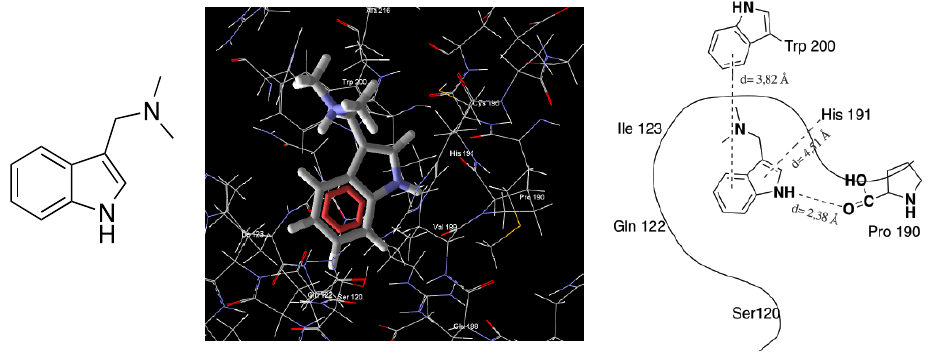
Figure 9. Structure of gramine and its pose at the PP2A-C binding site (Right, schematic view). According to the computational prediction based on molecular docking, the presence of an ionizable tertiary amine was preserved to favor interaction with PP2A, backed by the PP2A interactive behavior of some basic amines such as protamine. The aromatic indole scaffold presented in gramine would be highly stabilized (reducing the rate of the retro-Mannich reaction) if the aromatic nitrogen was alkylated. Thus, several substitutions were challenged, for instance, benzyl, n-butyl, propargyl, and so on, which in turn could generate an additional hydrophobic interaction with neutral amino acids present in the binding site of PP2A-C, far from the phosphate ester hydrolysis catalytic triad [165]. Fi- nally, substitution at C5 of the indole core was diversely probed, incorporating methyl, halogens, or no substitution, to assess the different interactive possibilities with the en- zyme [166]. Three dozen gramine derivatives were prepared by this straightforward method, and the ionized formulation facilitated drug solubility and their testing in further in vivo models. Their ability to recover phosphatase activity was monitored by the pNPP method in SH-SY5Y cultures subjected to OA. They showed a docile increase in phospha- tase activity. In parallel, using patch-clamp recordings and fluorescence experiments with the Ca 2+ -sensitive probe Fluo-4, we appreciate an important blocking effect on high K + - evoked depolarization, whereby we hypothesized these compounds were acting as VGCC antagonists, too. In most cases, those compounds capable of performing such a dual phar- macological, pro-PP2A and VGCC blockade, illustrated a very noticeable neuroprotective profile in the experimental in vitro model of the SH-SY5Y cells exposed to either OA or depolarizing stimuli such as veratridine. The best compounds of the series confirmed their neuroprotective capability in hippocampal slices challenged with glutamate. Molecular docking predicted that the new gramine derivatives posed in a binding pocket of PP2A- C defined by the amino acids His191, Ser120, Trp200, and Ile123, residues far from the catalytic site, but that it contributes to drug affinity. In addition, Western blot analyses proved that the most highlighted compounds such as ITH12657 or the chlorinated deriv- ative ITH12691 reduced the OA-induced tau phosphorylation rate [165,166] (Figure 10). Because of the PAD role of ITH12657, together with its important VGCC activity, prefer- entially to the P/Q subtype, it is currently under investigation for the treatment of neuro- pathic pain and retinopathies, indications where PP2A and the VGCC play a chief role (Figure 11). As far as ITH12691 is concerned, its global pharmacological profile has ad- dressed the characterization to appraise its potential in neurodegeneration, as preliminary experiments anticipate that it could augment the discrimination index of LPS-subjected mice, according to the object-location memory task.